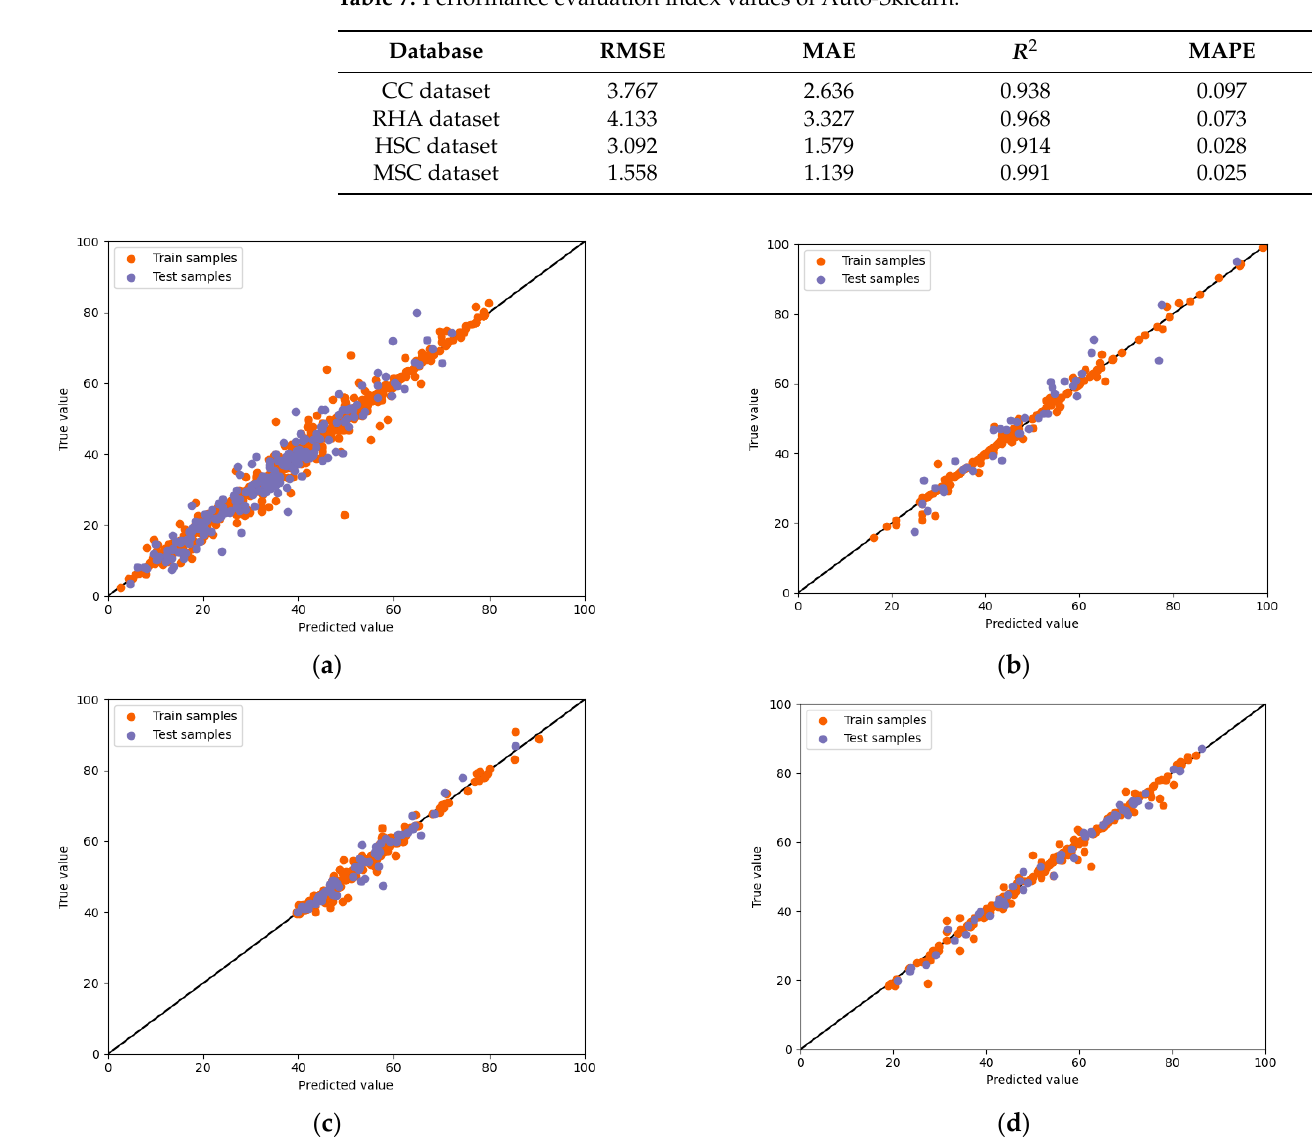
Table 7. Performance evaluation index values of Auto-Sklearn.